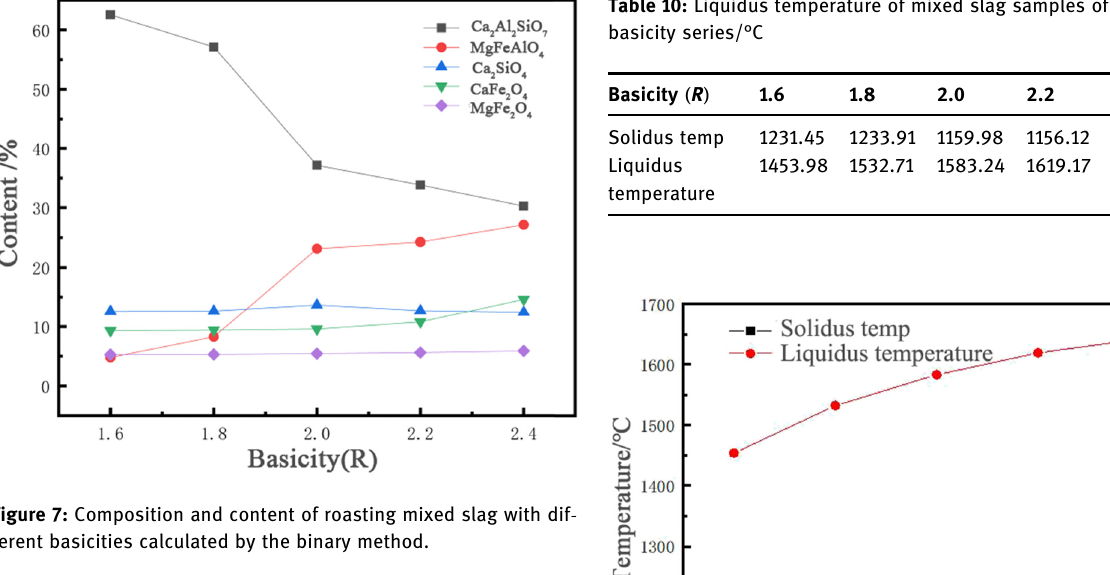
Table 10: Liquidus temperature of mixed slag samples of variable